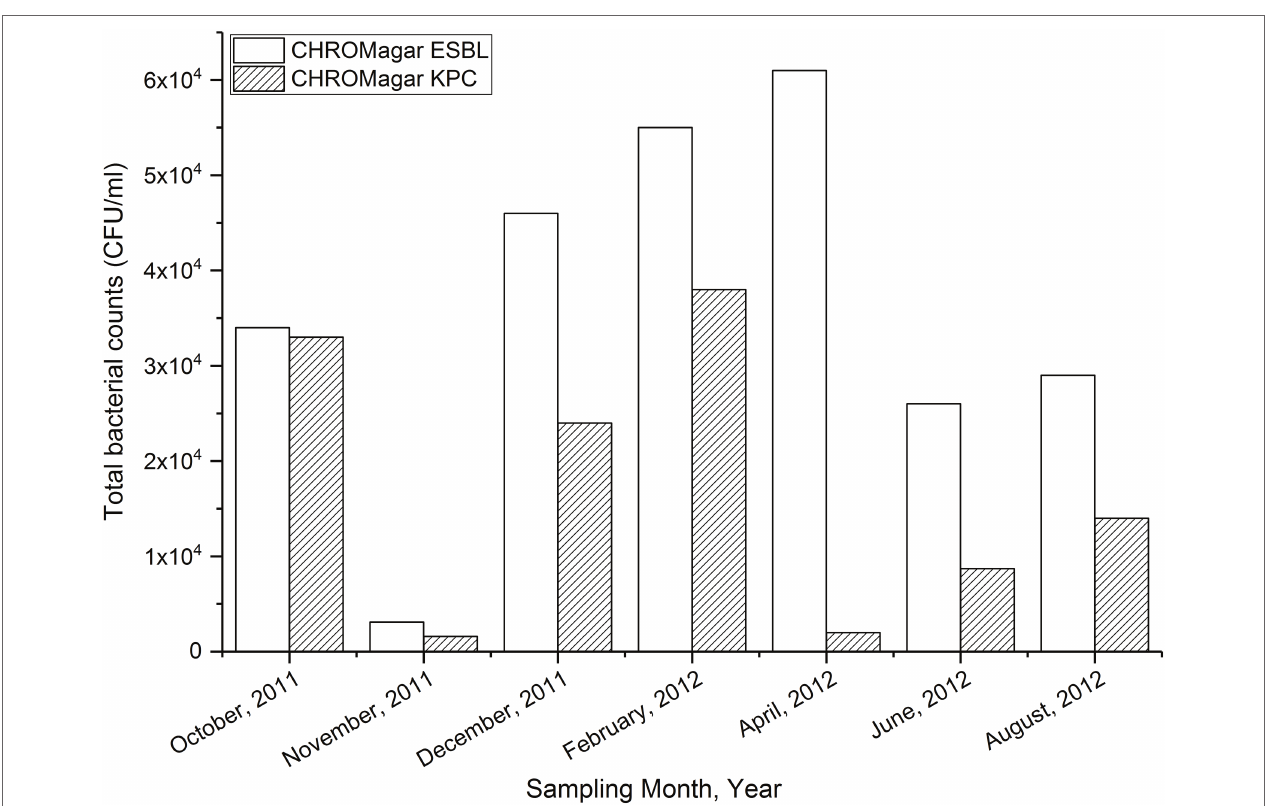
FIGURE 1 | The monthly variation in the bacterial growth on CHROMagar ESBL and CHROMagar KPC